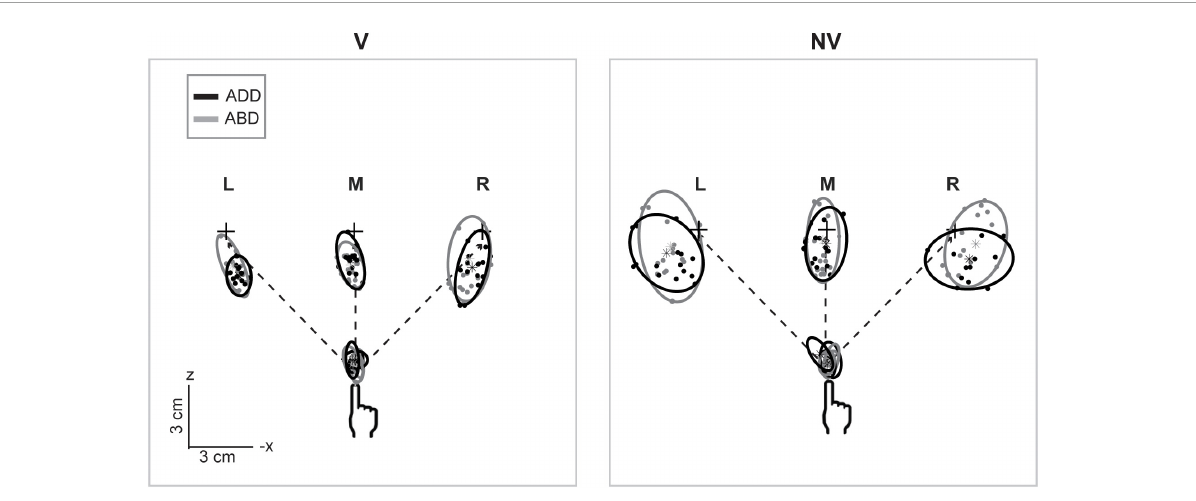
FIGURE2 Top-down view of movement starting points and endpoints and associated 95% confidence ellipsoids for reaches to the left (L), middle (M), and right (R) targets for a representative participant. Dashed lines show the straight-line paths to each target. Ellipsoids were generally larger and more variable in shape and orientation in the NV condition. Effects of arm posture were also more apparent in the NV condition, particularly with regard to ellipsoid positions and